Question: Summarize what this figure shows in one sentence.
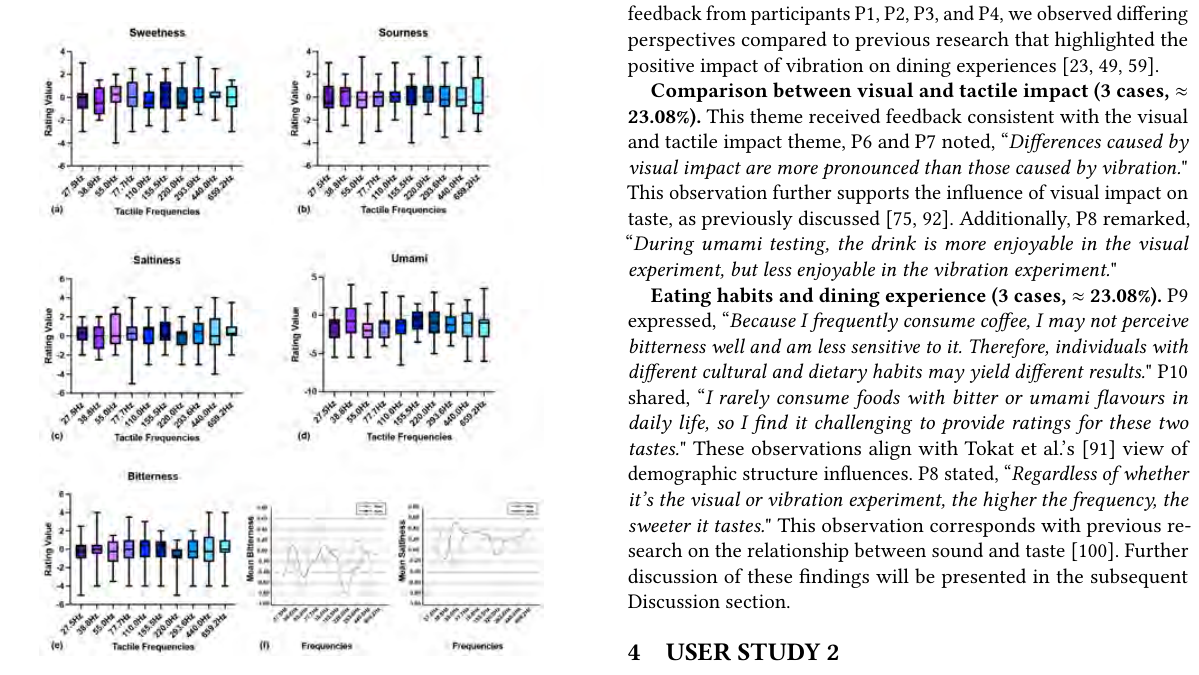
Answer: (a)-(e) Flavour ratings in￿uenced by tactile impact generated through cymatics (f) The correlation between vi- sual frequencies and tactile frequencies